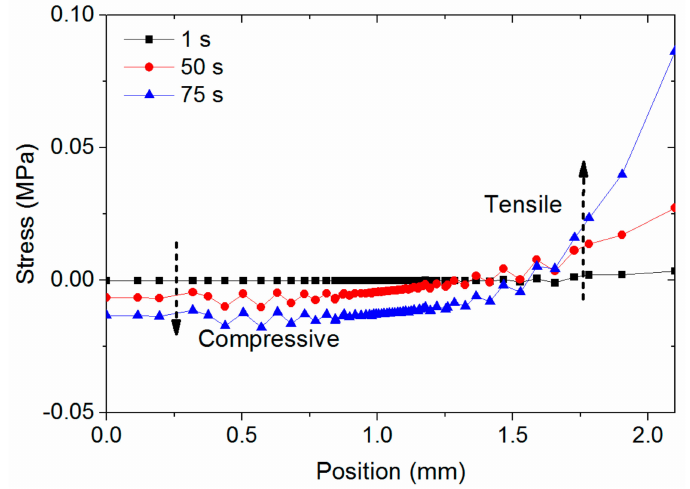
Figure 10. Stress evolution in stage